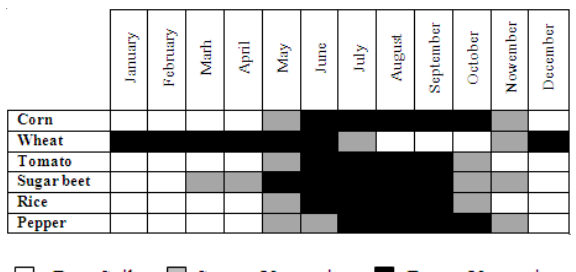
Table 1 Phenological characteristic of the main crop types